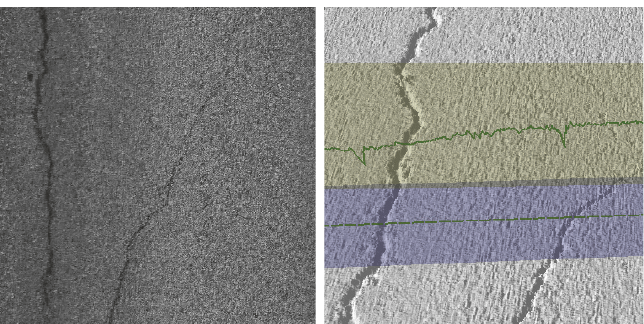
Figure 1: The 2D pavement image (left) and 3D pavement image (right): the up green line is the transverse profile of a patch of pavement surface.